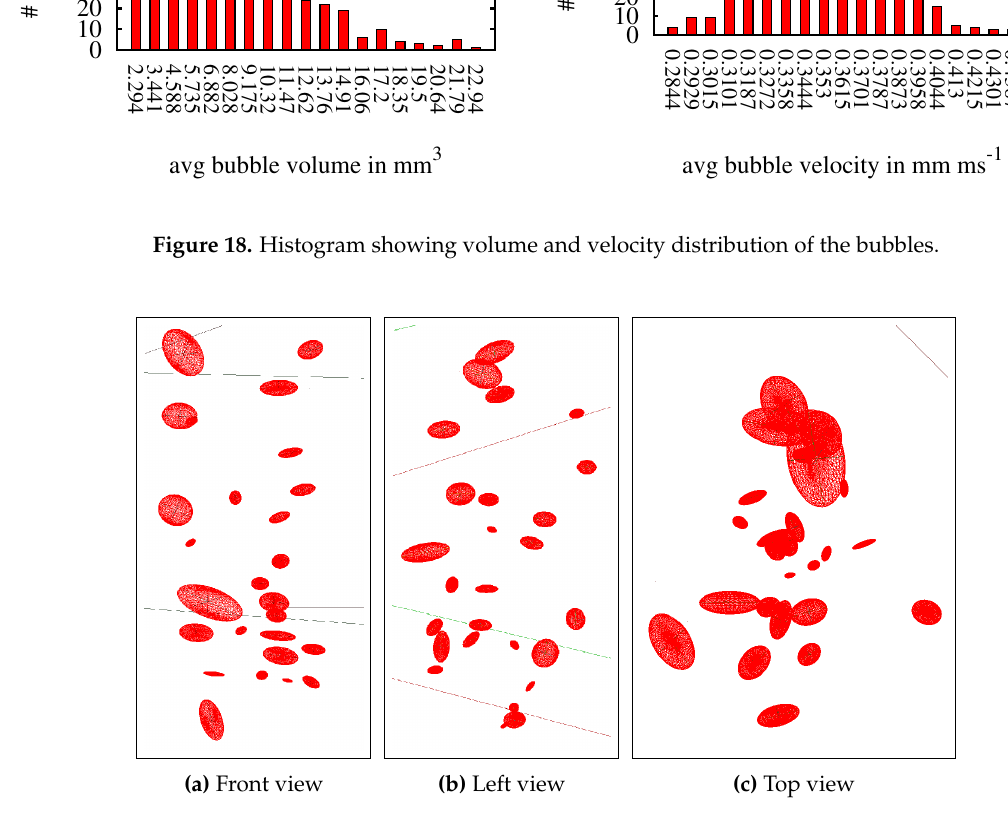
Figure 19. 3D-Reconstruction of a bubble